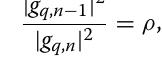
The direct path The direct path parameters for the q -th BS consist of only g q ,0 and ω q ,0 , because θ q ,0 can be deter- mined form x 0 and y 0 . In this paper, ∠ g q ,0 is drawn from a uniform distribution over [ 0, 2 π) , and | g q ,0 | is obtained, based on the free-space path loss model. Assume the vari- ance of w q , k , m is σ 2 = 1. Also, recall that the gain of each antenna is 0 dB. Thus,